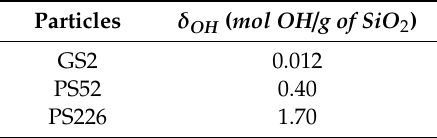
Table 3. Density of the surface silanol groups of all the three types of particles used in the present study.